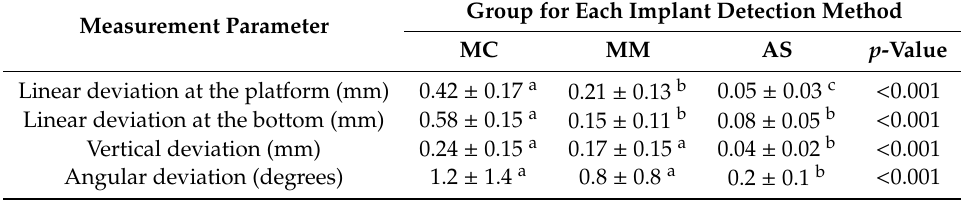
Table 1. Values of geometric discrepancy between the estimated and actual positions of the implant using di ff erent detection methods.